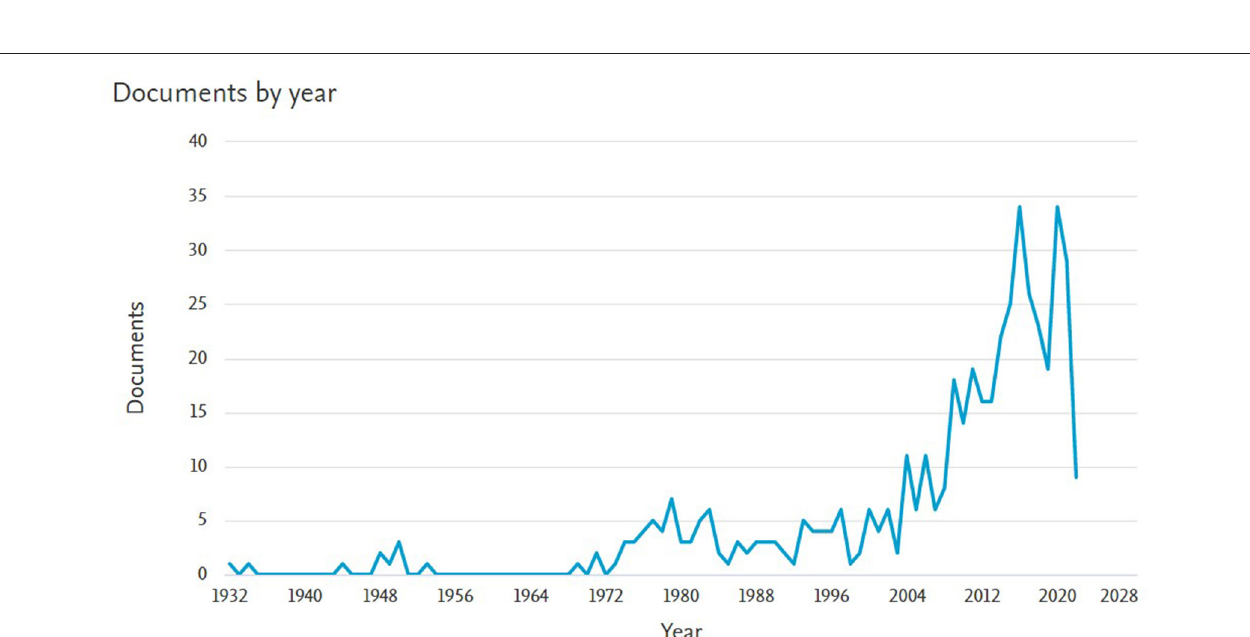
FIGURE 2 | Records found in Scopus for the keyword